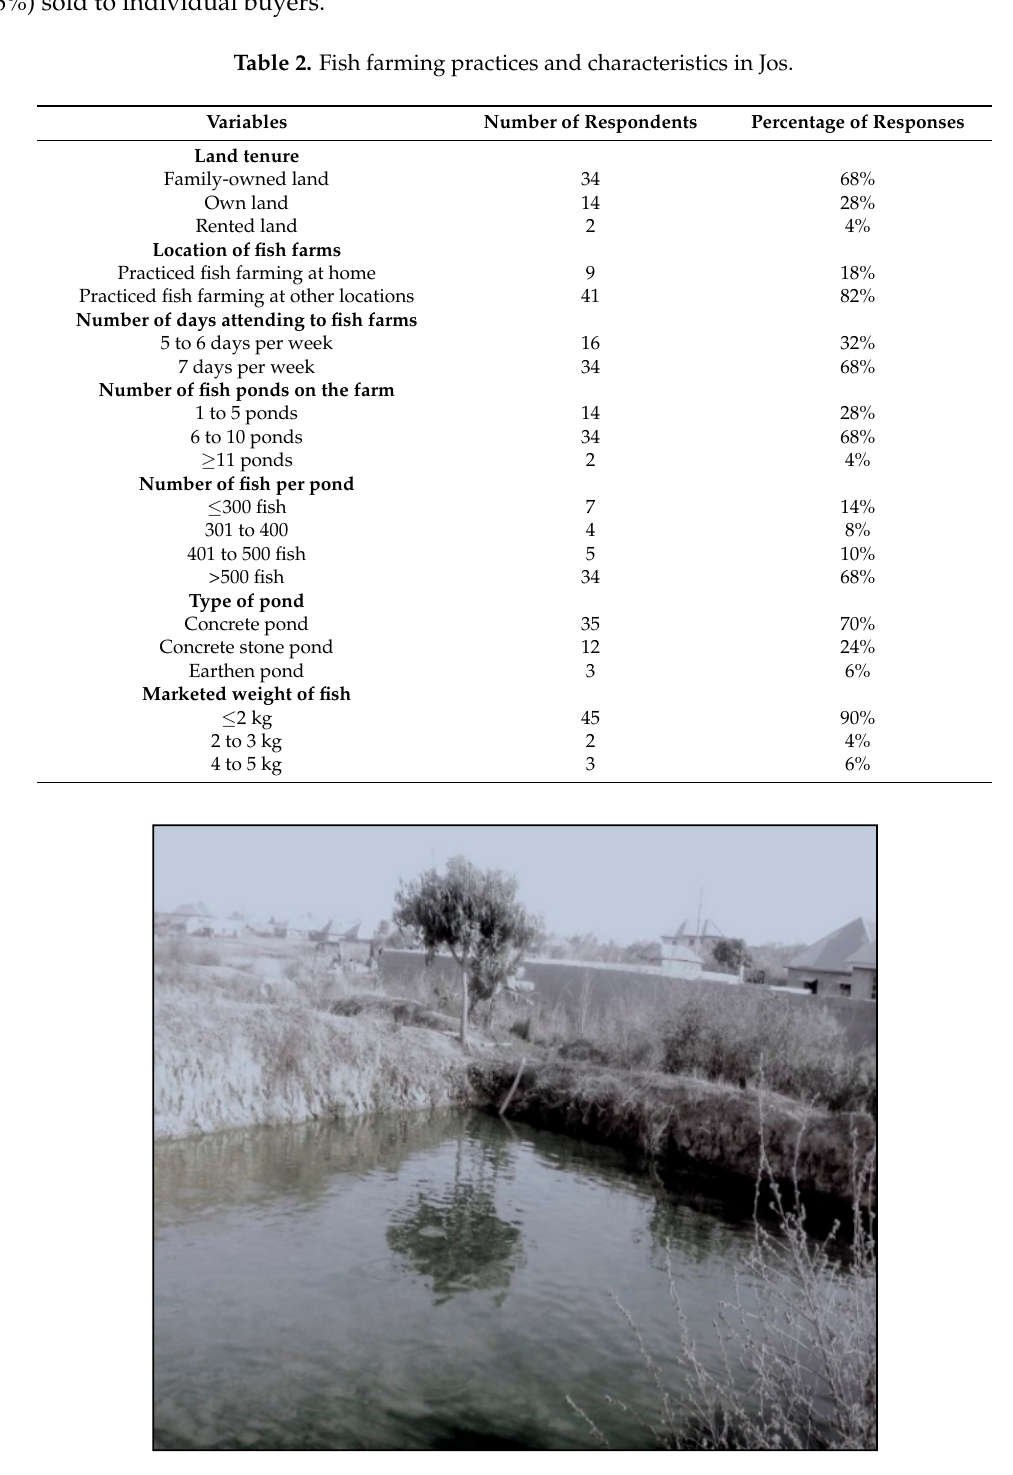
Figure 2. Earthen ponds.